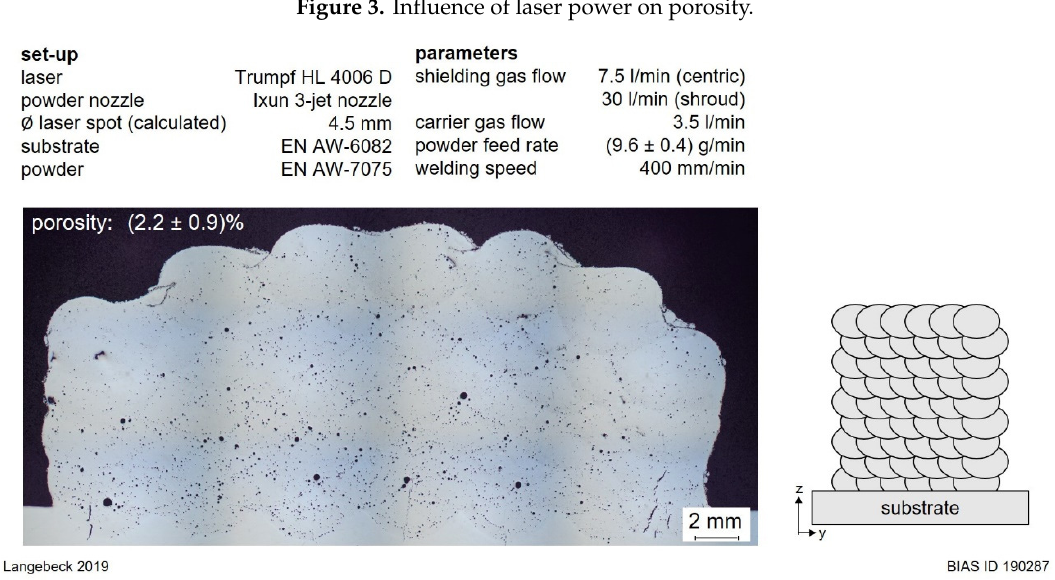
Figure 3. Influence of laser power on porosity.